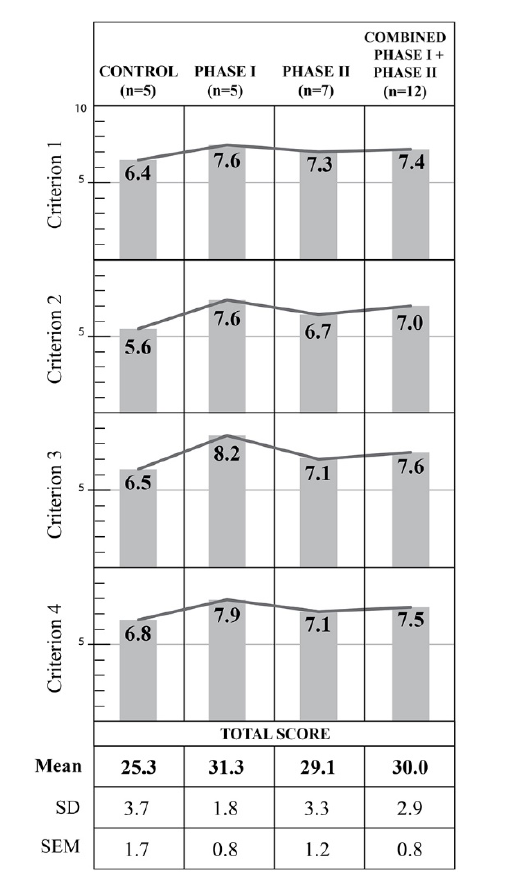
Figure 1 Average student performance for each DEBUT